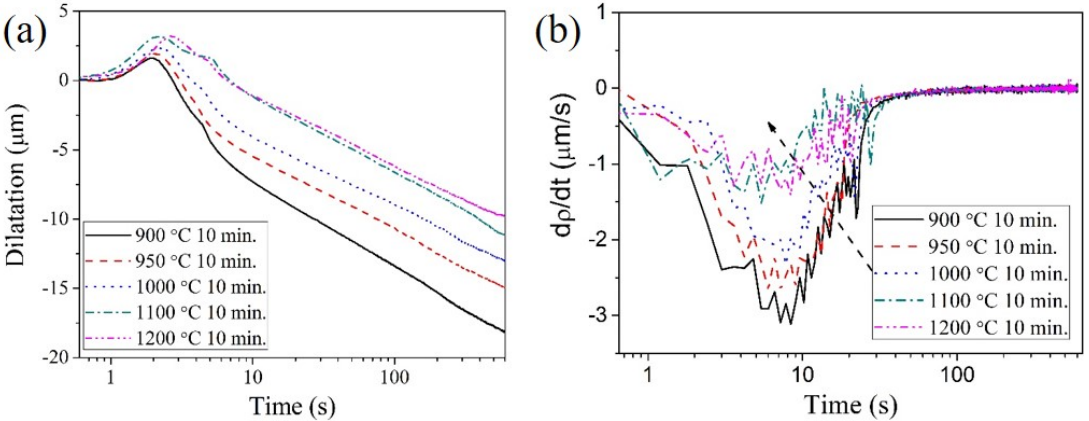
Figure 8. ( a ) The change in length of the present steel during the reverse transformation from martensite with varied grain size. ( b ) The corresponding transformation velocity of the reverse transformation.